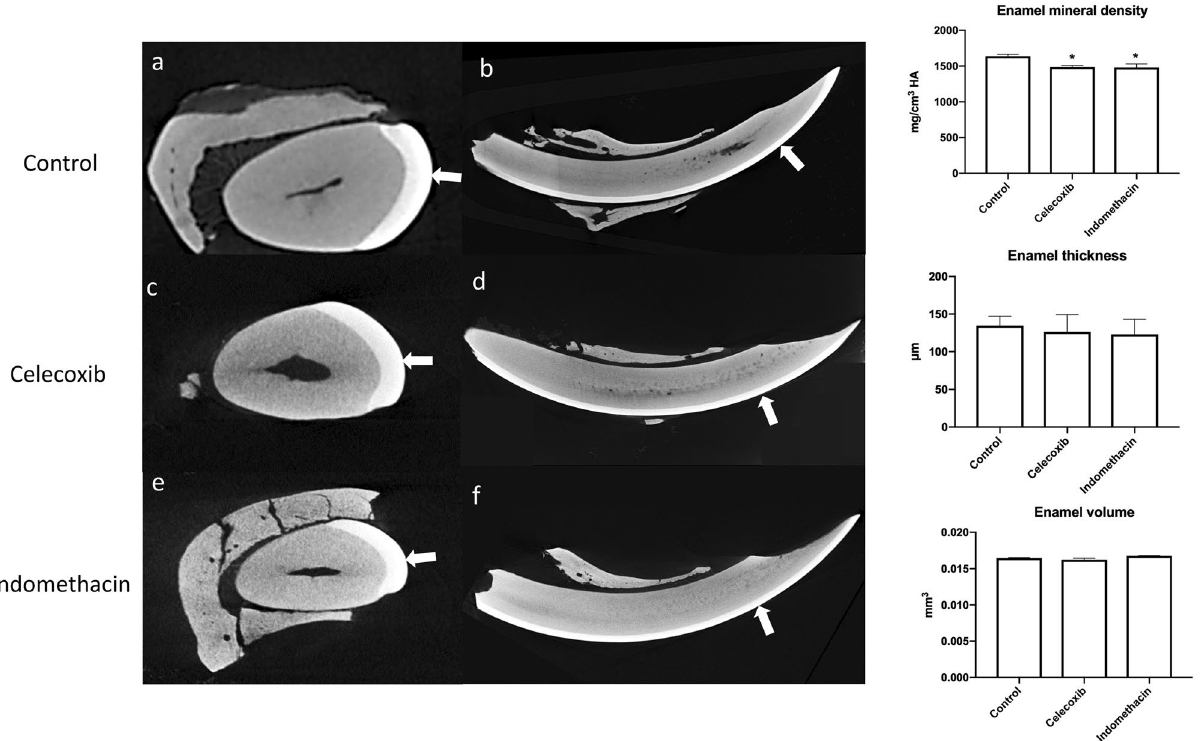
Figure 1. Micro-computed analysis (μCT) of mandibular incisors. Axial images ( a , c , e ) show the enamel layer of the three groups. In sagittal images ( b , d , f ) with white arrows that indicates the mature enamel segment which is about to erupt in oral cavity